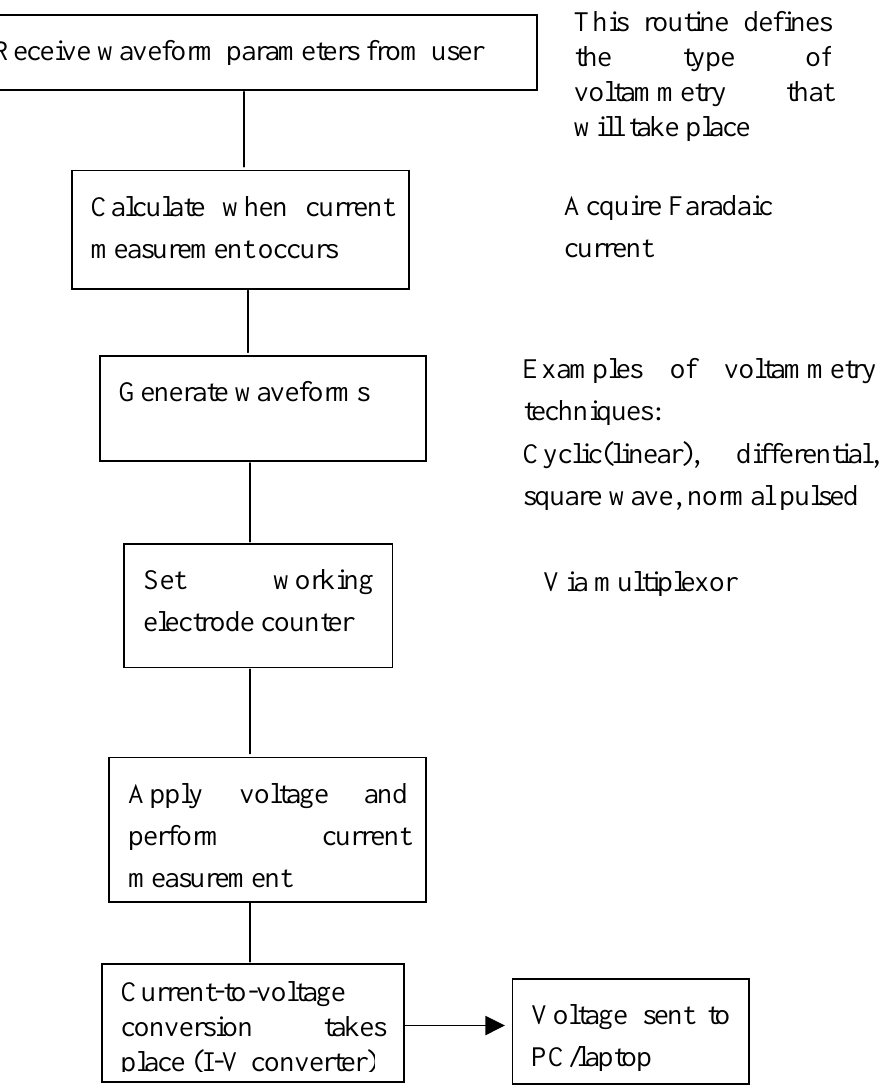
Figure 5. A flow diagram showing the routines that occur when the user initiates the MATLAB